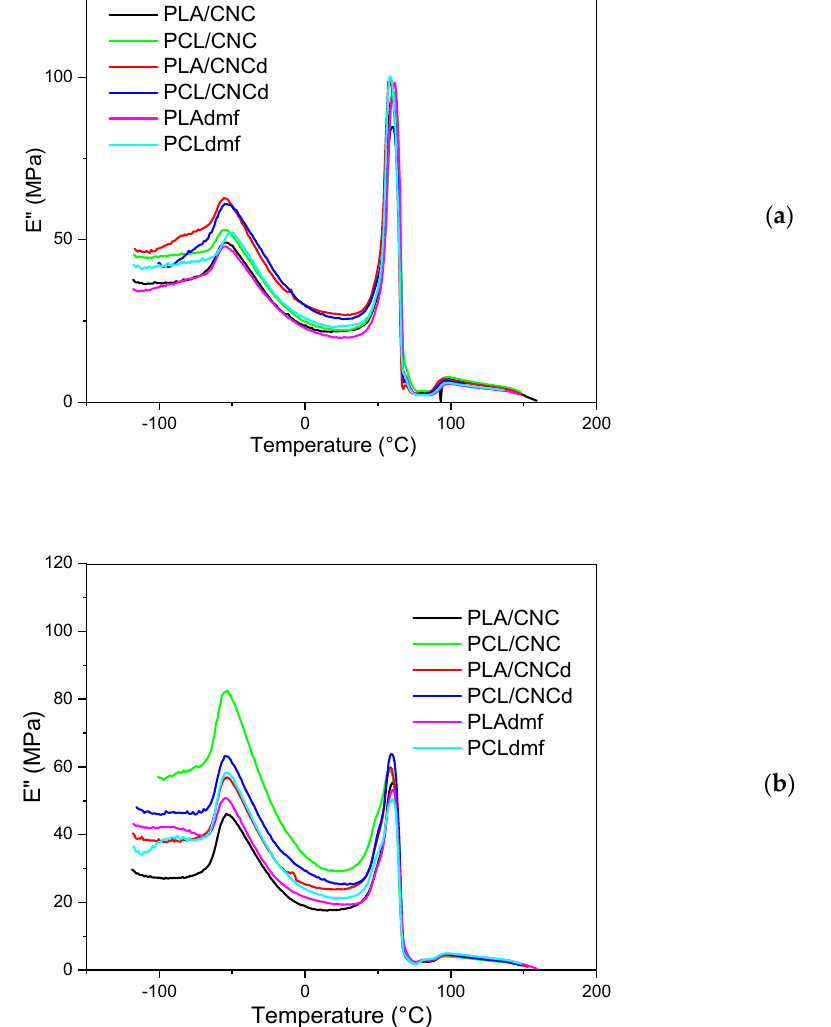
Figure 7. Temperature dependence of loss modulus of ( a ) 60/40 PCL/PLA ratio, and ( b ) 40/60 ratio.